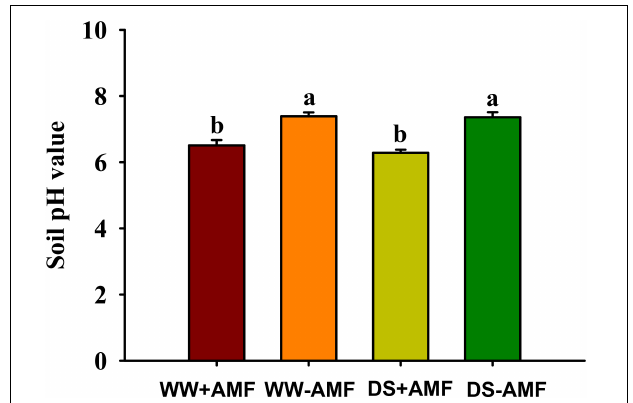
FIGURE 6 | Effects of Funneliformis mosseae on leaf and root ammonium contents in trifoliate orange ( Poncirus trifoliata ) seedlings subjected to well-watered (WW) and drought stress (DS). Data (means ± SD, n = 4) followed by different letters above the bars indicate significant differences ( P < 0.05) between